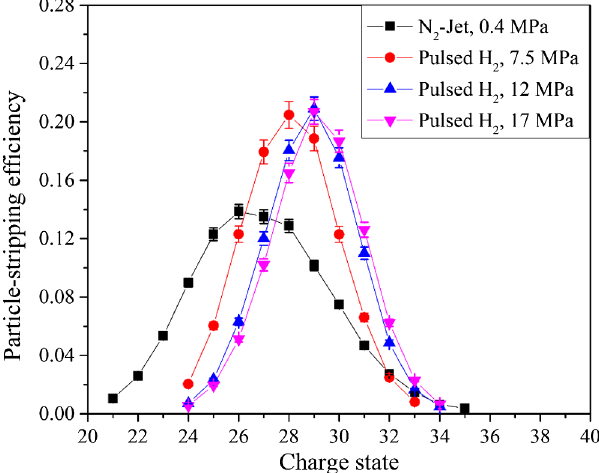
FIG. 2. Charge distribution after stripping of uranium projec- tiles in a H 2 gas target for different target thickness (maximum average charge distribution is depicted in pink color); uranium beam on a N 2 target is shown as